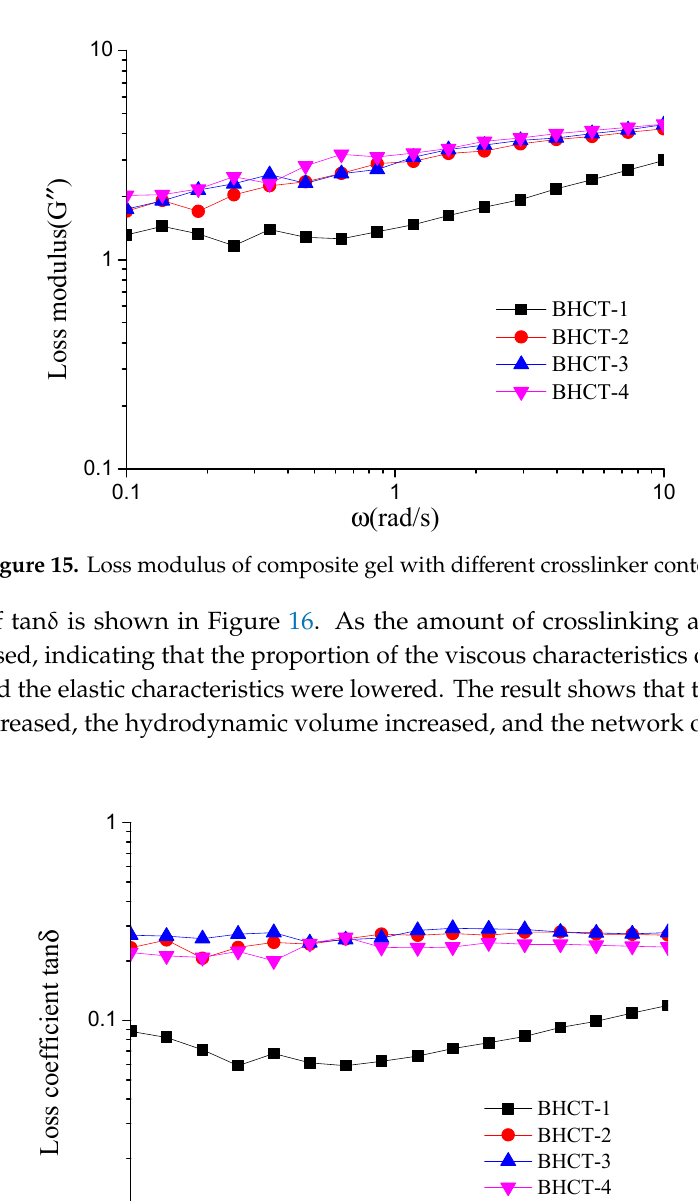
Figure 14. Elastic modulus of composite gel with different crosslinker contents.